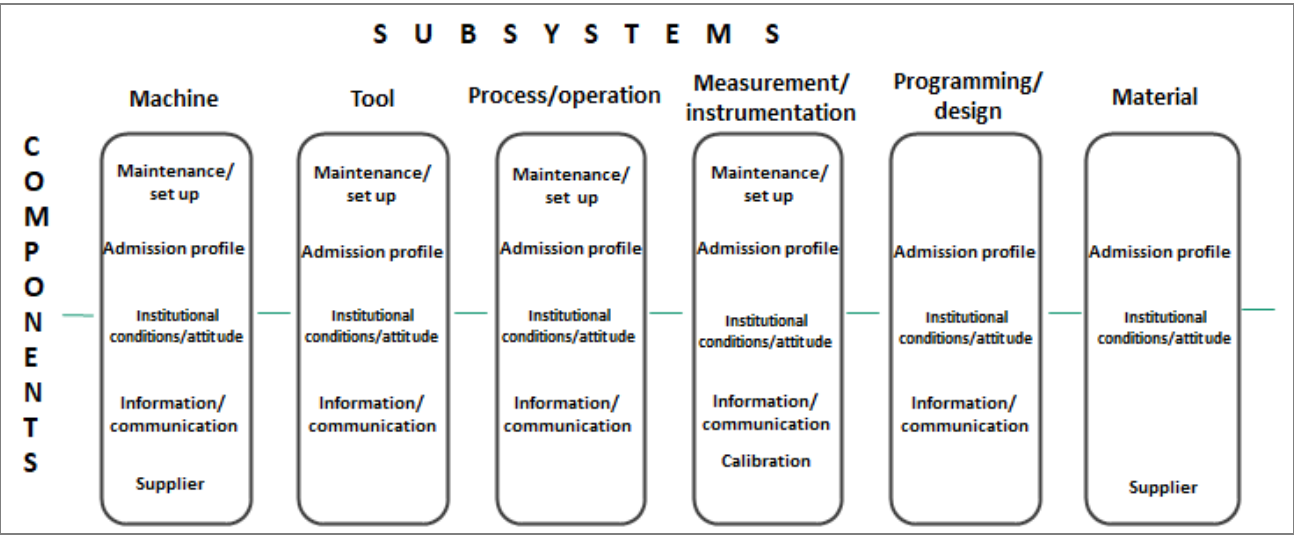
Figure 4. Human–machine system of the machine tool.